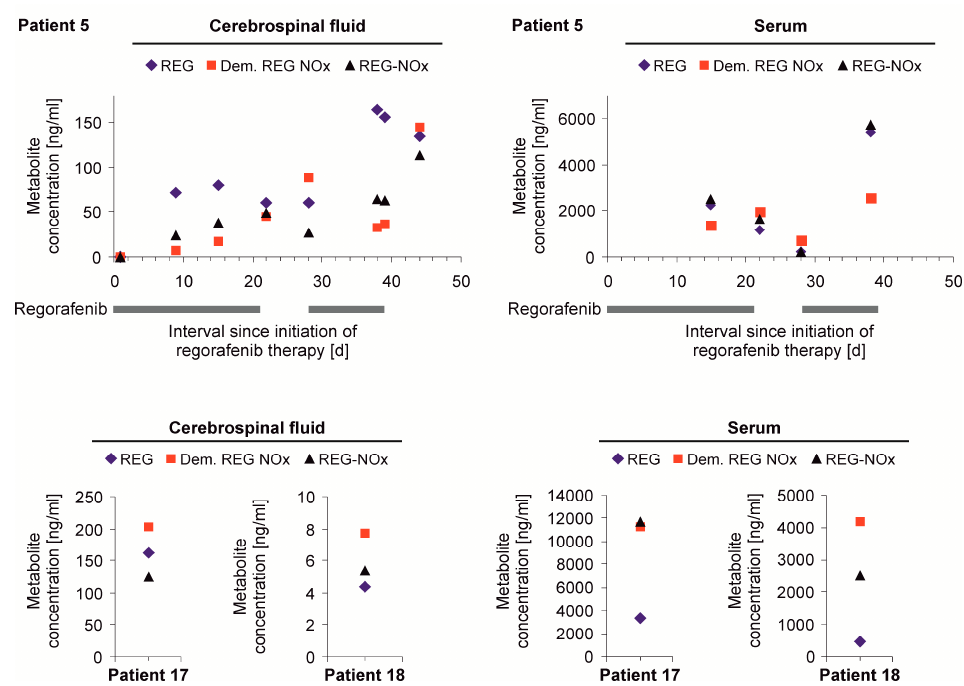
Figure 1. Cerebrospinal fluid (CSF) and serum levels of regorafenib (REG). CSF and serum of patients 5, 17, and 18 was preserved during several time points of REG treatment. The concentrations of REG (blue diamonds) and the active REG metabolites demethylated REG N-oxide (red squares) and REG N-oxide (black triangles) are depicted. Ventricular CSF of patient 5 was obtained via Rickham reservoir puncture at different time points during treatment with REG (indicated by black bars, upper panel). For patients 17 and 18, only one sample at a single time point was available (lower panel). Lumbar puncture was performed in patient 17 on the first day of the second cycle of REG treatment (4.5 h after administration). In patient 18, the lumbar puncture was performed on day 22 of the first cycle, however the patient stopped REG after day 19 (>48 h after the last administration).